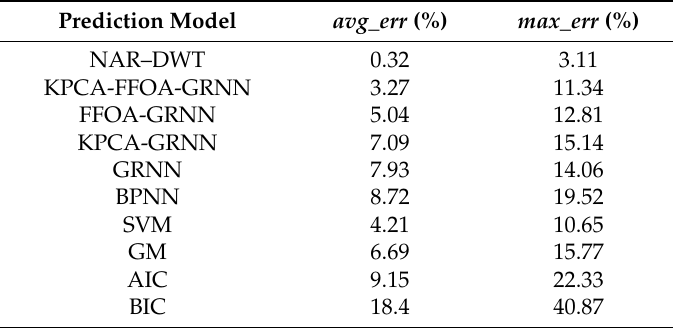
Figure 3. Prediction versus target values of hydrogen in-oil concentration. Table 5. Prediction error for the ethylene gas by different models.